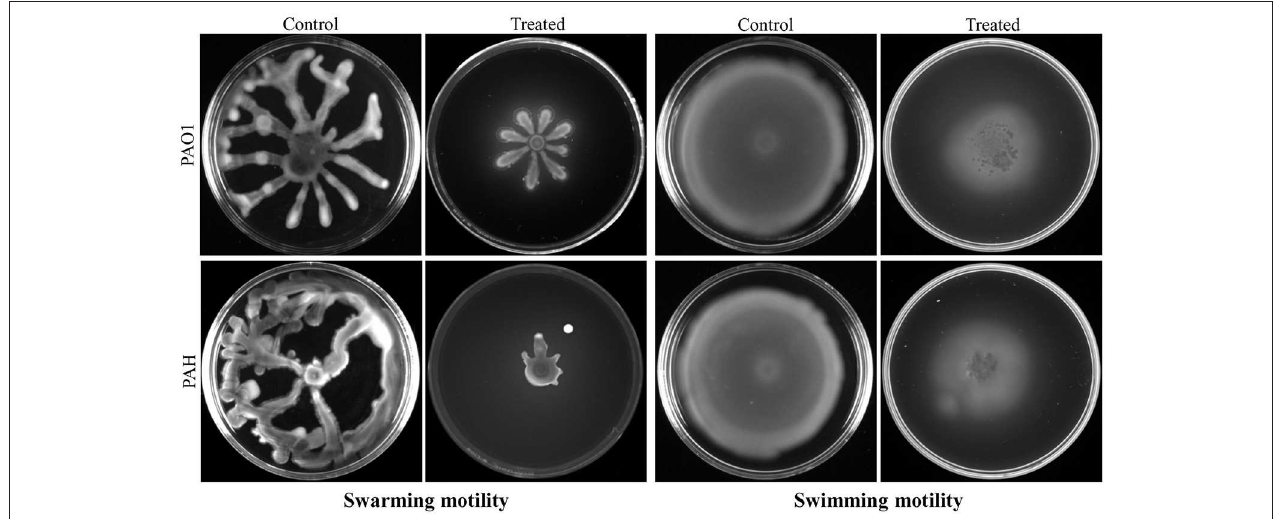
FIGURE 7 | Study of cell motility of P. aeruginosa . The effect of bacterial extract ( D. tsuruhatensis SJ01) on the swarming and swimming motility of reference P. aeruginosa strains was studied. P. aeruginosa was spotted on a plate supplemented with (0.1 mg/ml) or without extract. Plates were analyzed after incubation of 24 h at 37 ◦ C.